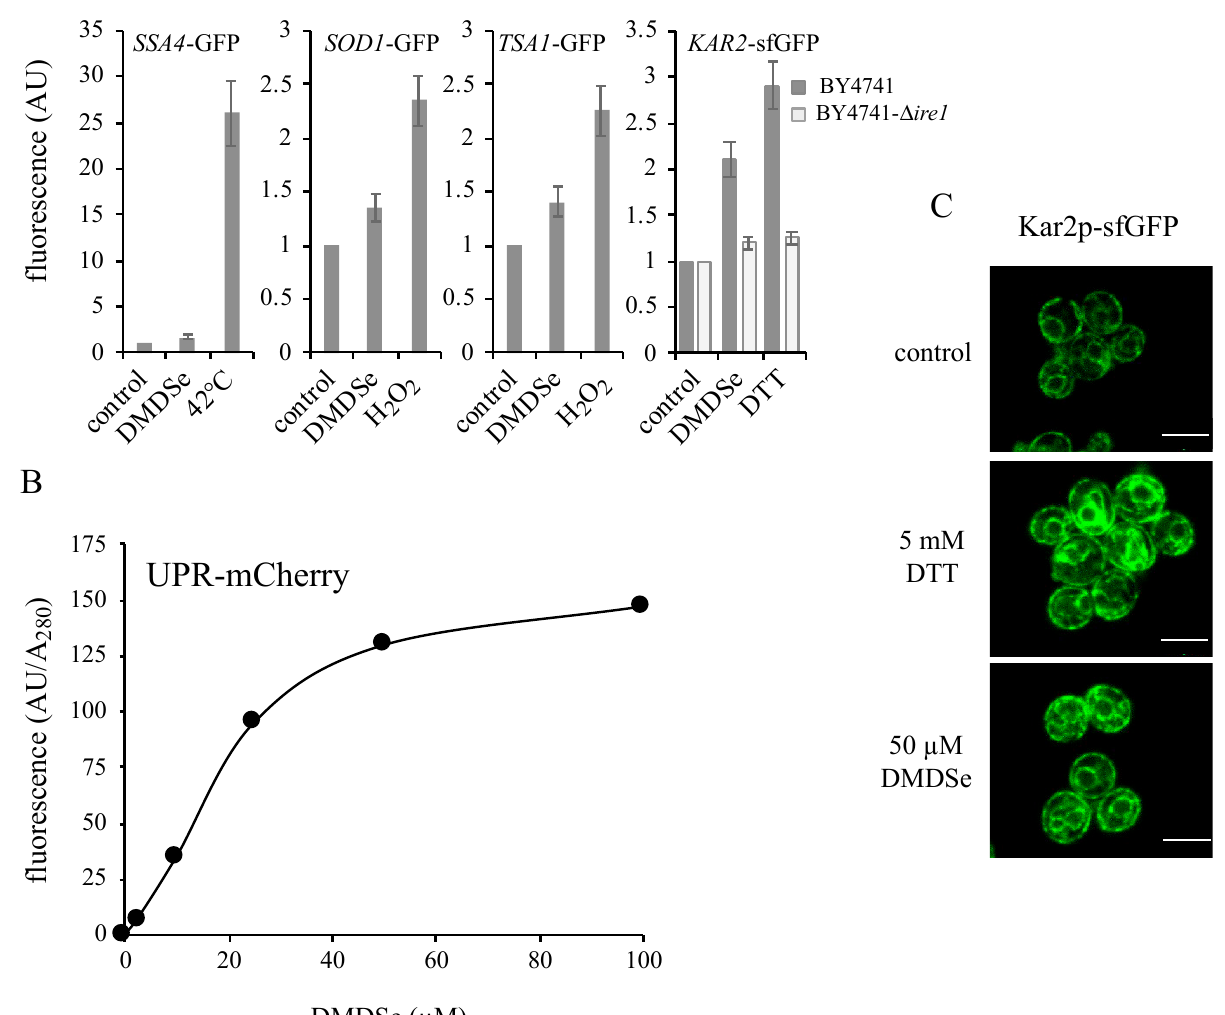
Figure 2. Cellular stress response to DMDSe exposure. ( A ) Fluorescence at 508 nm of whole cell extracts of BY4741 cells with a chromosomally integrated GFP-tagged construct, as indicated in the different panels, after incubation in SC + 100 Figure 1. Cell growth inhibition by methylselenol (MeSeH) precursors. Exponentially growing BY4741 cells in SC medium µM methionine for 2 h at 30 °C (control) or 42 °C in the same medium, or at 30 °C in the additional presence of 100 µM DMDSe, 4 mM H 2 O 2 or 5 mM DTT. The fluorescence of the Kar2p-sfGFP protein was determined in BY4741 ( ) or in ∆ ire1 supplemented with 100 µM methionine were diluted to 0.1 OD 600 in the same medium and left to grow for 2 h. At time zero, 0 (  ), 25 ( ) or 100 µM (  ) of methylselenoglutathione (MeSeSG) ( left panel ) or dimethyldiselenide (DMDSe) ( right ( ) cell extracts. The fluorescence in whole cell extracts was recorded at 508 nm and normalized to the optical density of panel ) were added and cell growth was monitored by measuring the OD 600 at various times during 6 h. Data were plotted the extracts at 280 nm. The fluorescence intensity in the absence of toxic (control) was set as 1. The results are the mean ± S. D. of at least 3 experiments. ( B ) BY4741 cells expressing the fluorescent protein UPR-mCherry were grown in SC without on a semi-log scale as a function of time. Doubling times of 119 ± 14 (control), 147 ± 16 (25 µM MeSeSG), 192 ± 19 (100 µM uracil supplemented with 100 µM methionine. After incubation for 2 h with the indicated concentrations of DMDSe, the MeSeSG), 157 ± 16 (25 µM DMDSe) and 223 ± 24 (100 µM DMDSe) min were calculated by using regression analysis. The fluorescence in whole cell extracts was recorded at 610 nm. The autofluorescence of an extract from BY4741 cells in the results are the mean and range of two experiments. absence of stress was subtracted from the results. ( C ) Kar2p-sfGFP localization was monitored by confocal fluorescence microscopy in living cells grown in SC + 100 µM methionine after 75 min of exposure to 50 µM DMDSe or 5 mM DTT. Bar equals 5